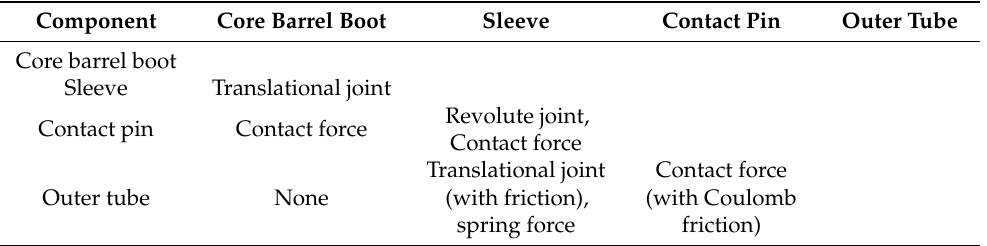
Table 1. Definition of relationship between motion and force of each component in ADAMS trig- ger mechanism.